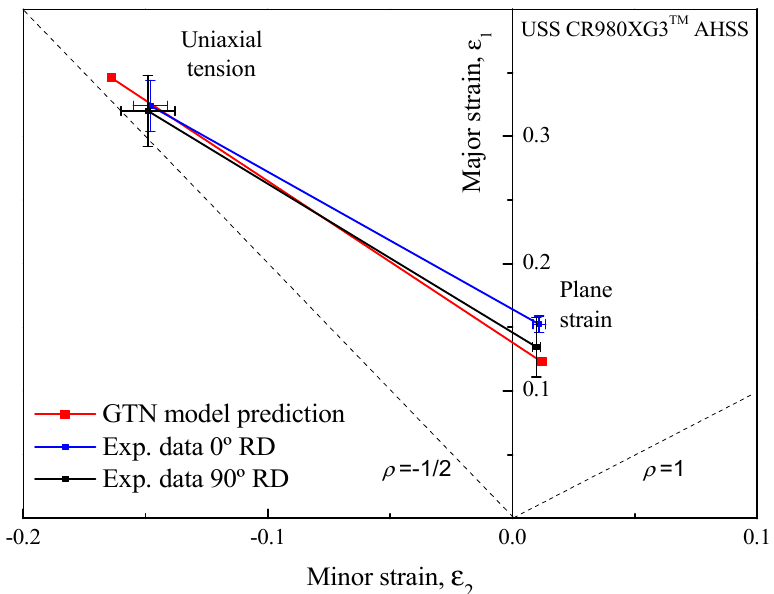
Figure 24. Comparison between the experimental left-hand side of the forming limit curve and the numerical prediction determined for the CR980XG3 TM steel sheet using flat specimens and the GTN model.